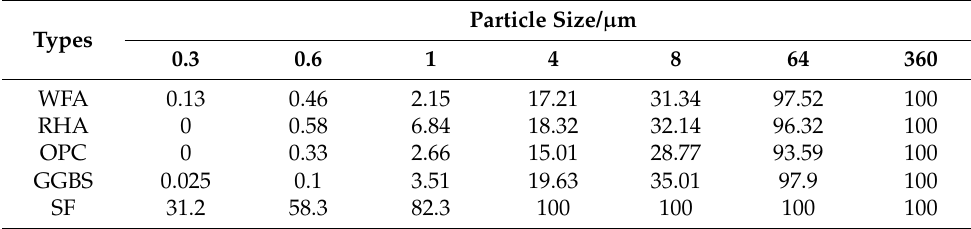
Table 2. Particle passing percentage of the cementitious materials/%.